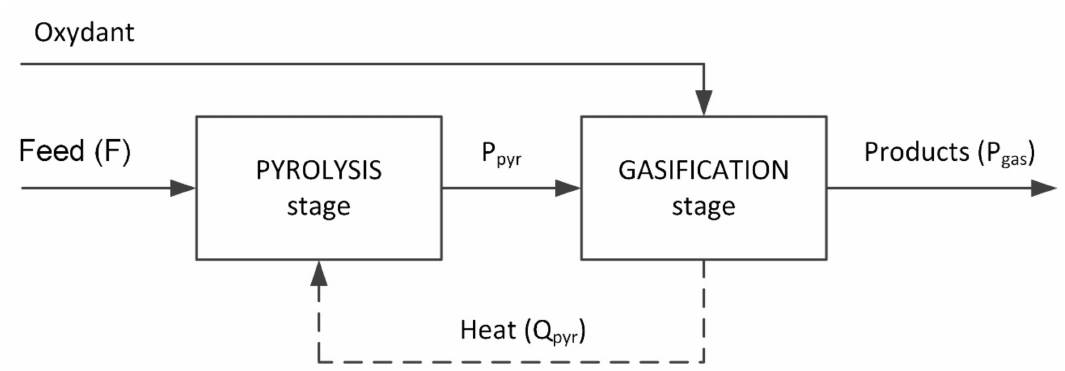
Figure 13. The block diagram of the entire gasification process (P pyr —intermediate products of pyrolysis